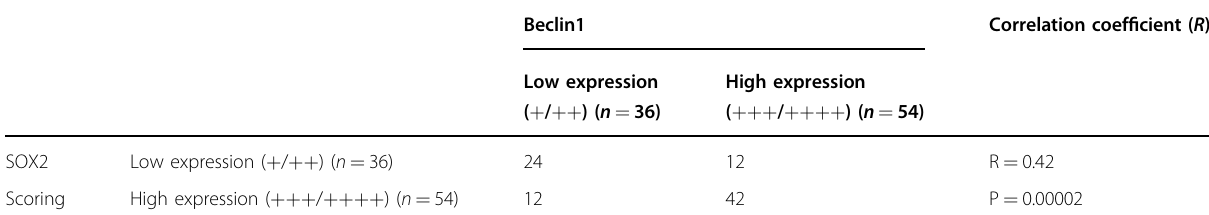
Table 2 Correlation between SOX2 and Beclin1 expression in CRC patients.